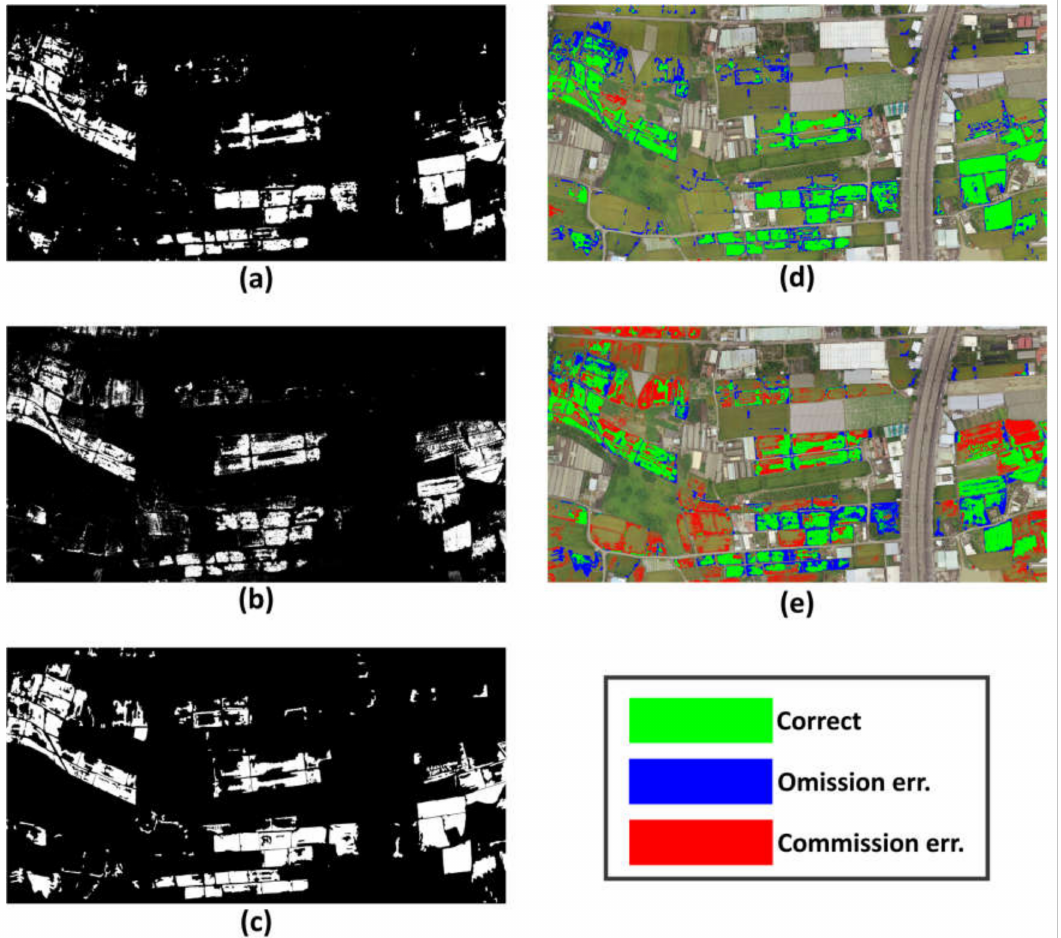
Figure 15. Results of rice lodging identification on 2019 testing dataset (white: rice lodging, black: others): ( a ) FCN-AlexNet using RGB + ExGR information, ( b ) SegNet using RGB + ExGR information, ( c ) ground truth. Results comparison with ground truth for ( d ) FCN-AlexNet using RGB + ExGR information and ( e ) SegNet using RGB + ExGR